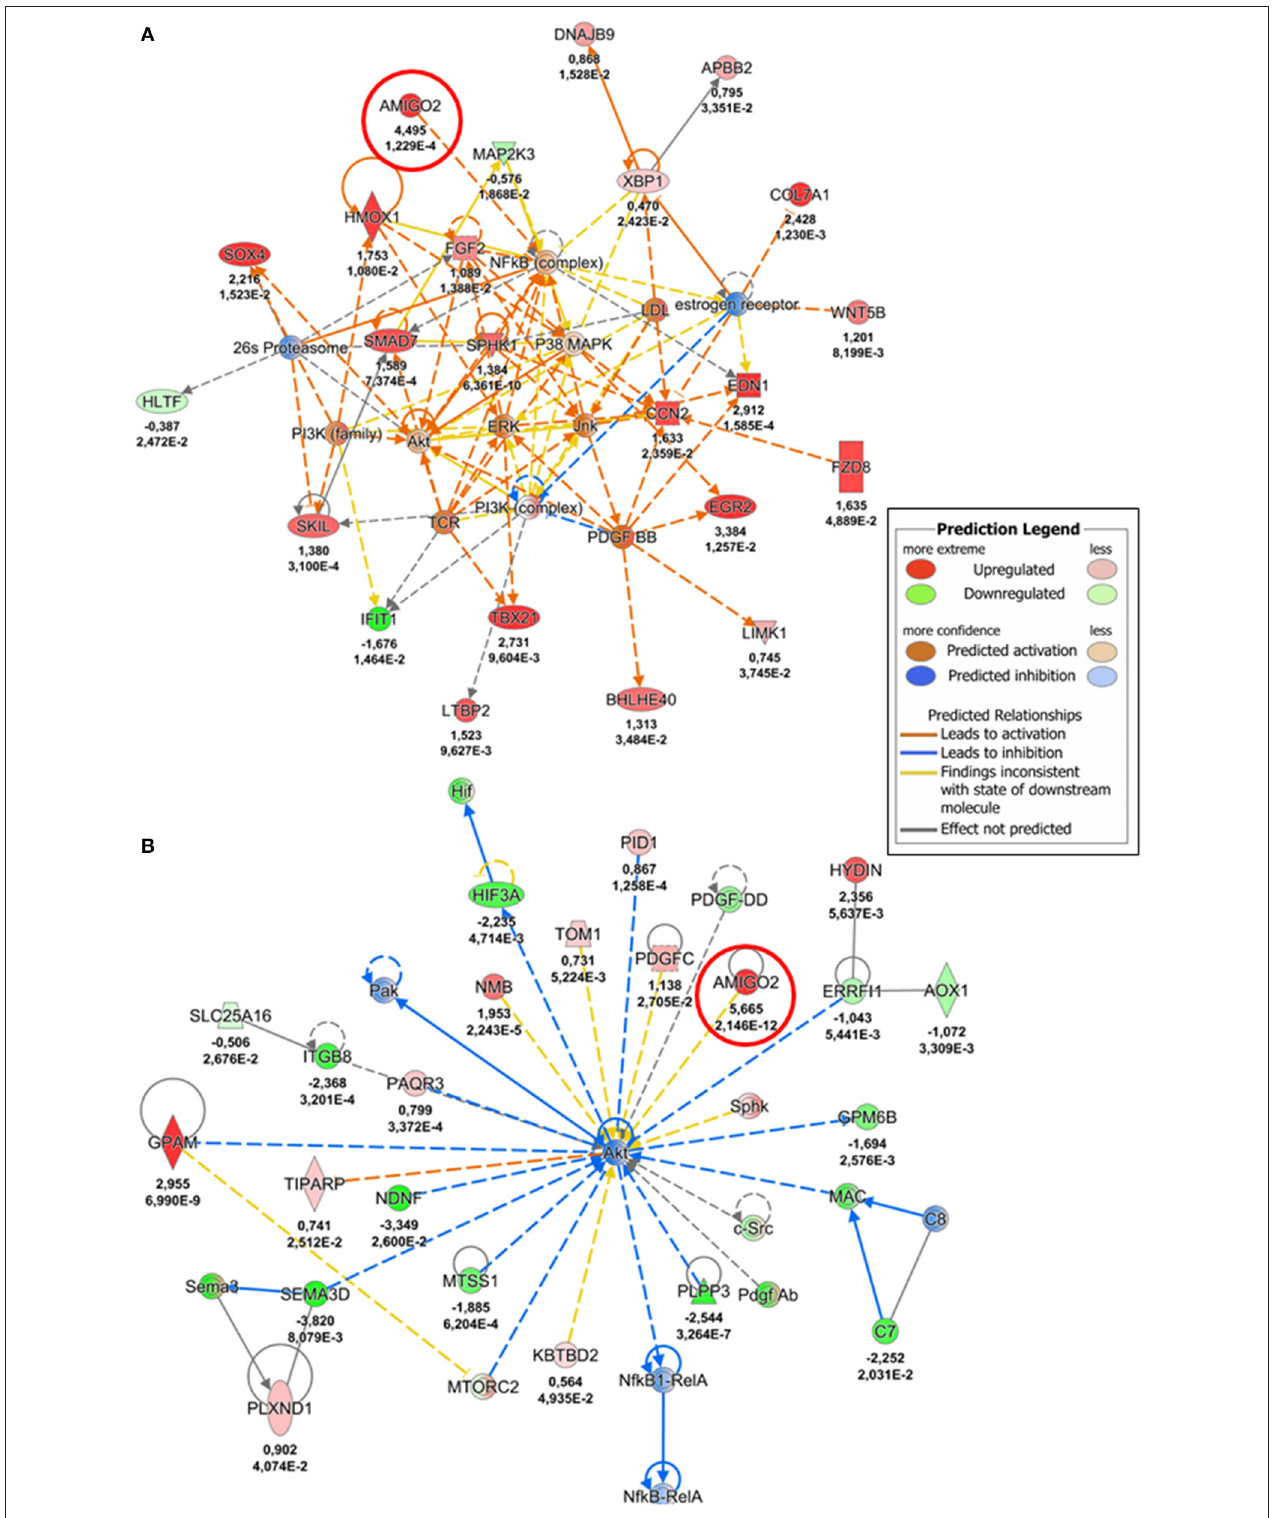
FIGURE 7 | AMIGO2-protein interaction networks. (A) Protein-protein interaction network involving AMIGO2, identified by IPA analysis (24 h dyn vs. 24h stat). (B) Protein-protein interaction network involving AMIGO2, identified by IPA analysis (72 h dyn vs. 72h stat). The values underneath each protein (when expressed in the dataset) indicate respectively the logFC and the adjusted p -value from the DE analysis. AMIGO2 is circled in red.